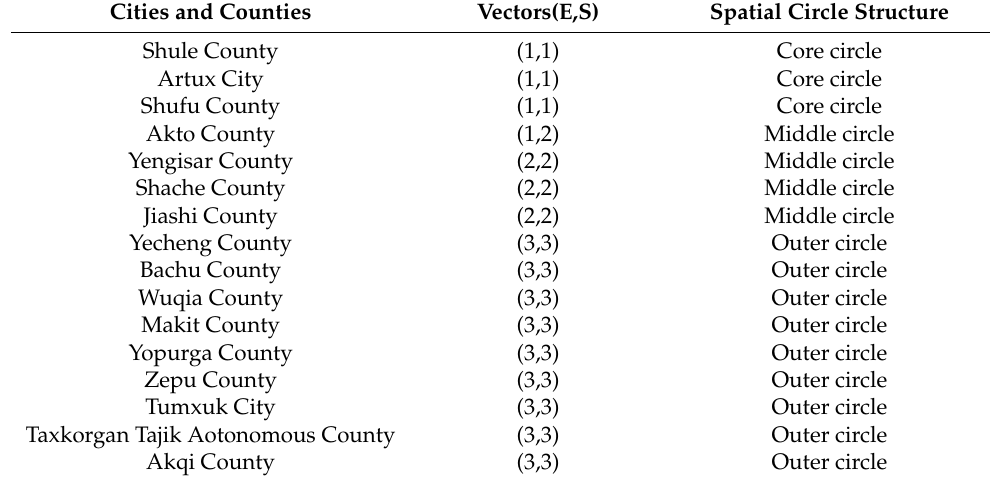
Table 6. The vector